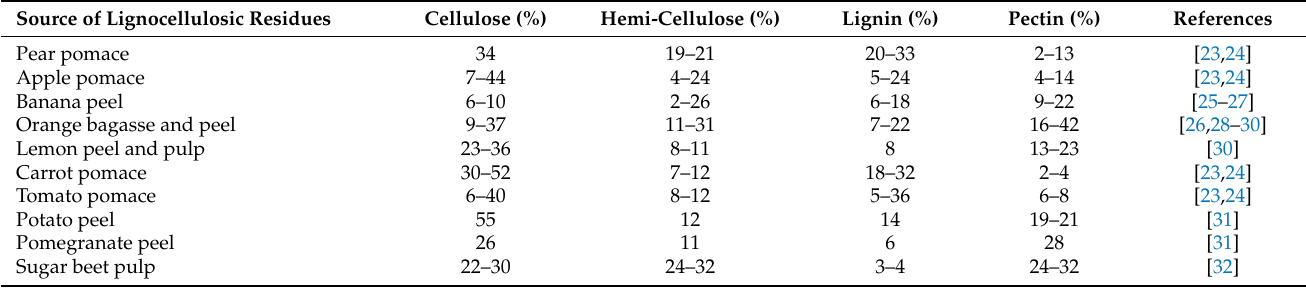
Table 2. Composition of some lignocellulosic materials discarded from processing